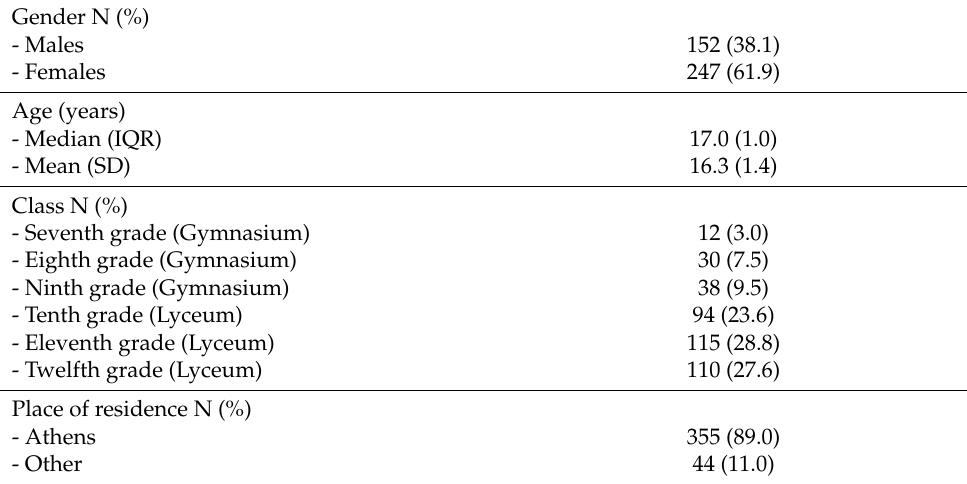
Table 1. Samples’ Sociodemographic characteristics (N =